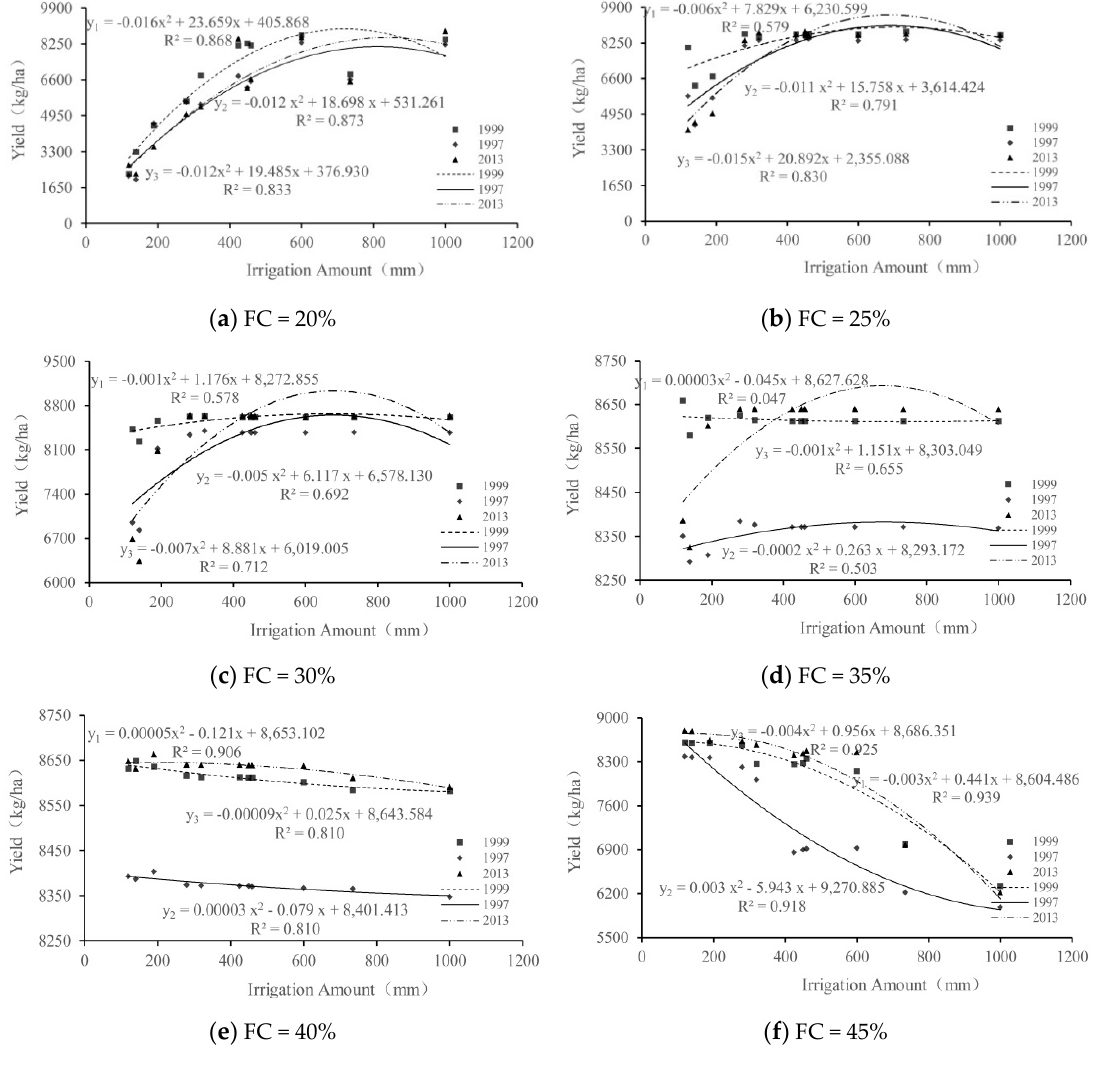
Figure 6. The fitting diagram of the irrigation water quantity and yield.